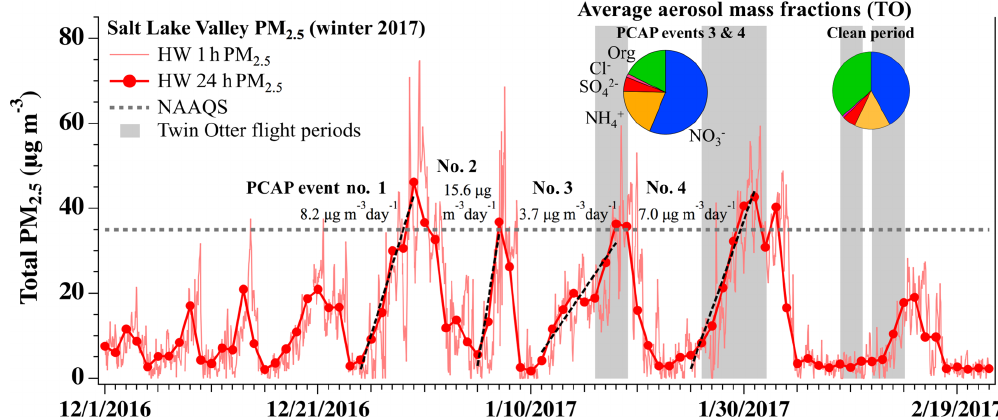
Figure 4. Time series of total PM 2 . 5 mass (µgm − 3 ) (1 and 24h averages) for the 2016–2017 winter, measured at the Hawthorne (HW) UDAQ site in the SLV. Dashed black lines are daily PM 2 . 5 accumulation rates (rates given in Figure). The 24h EPA national ambient air quality standard (NAAQS) for PM 2 . 5 (35µgm − 3 ) is shown by the dashed gray line. Gray shading indicates days when the TO aircraft was flying during UWFPS. Average aerosol mass fractions measured by the AMS aboard the TO are given in pie charts for polluted and clean conditions. Aerosol components are colored by nitrate (blue), ammonium (gold), sulfate (red), non-refractory chloride (pink), and organics